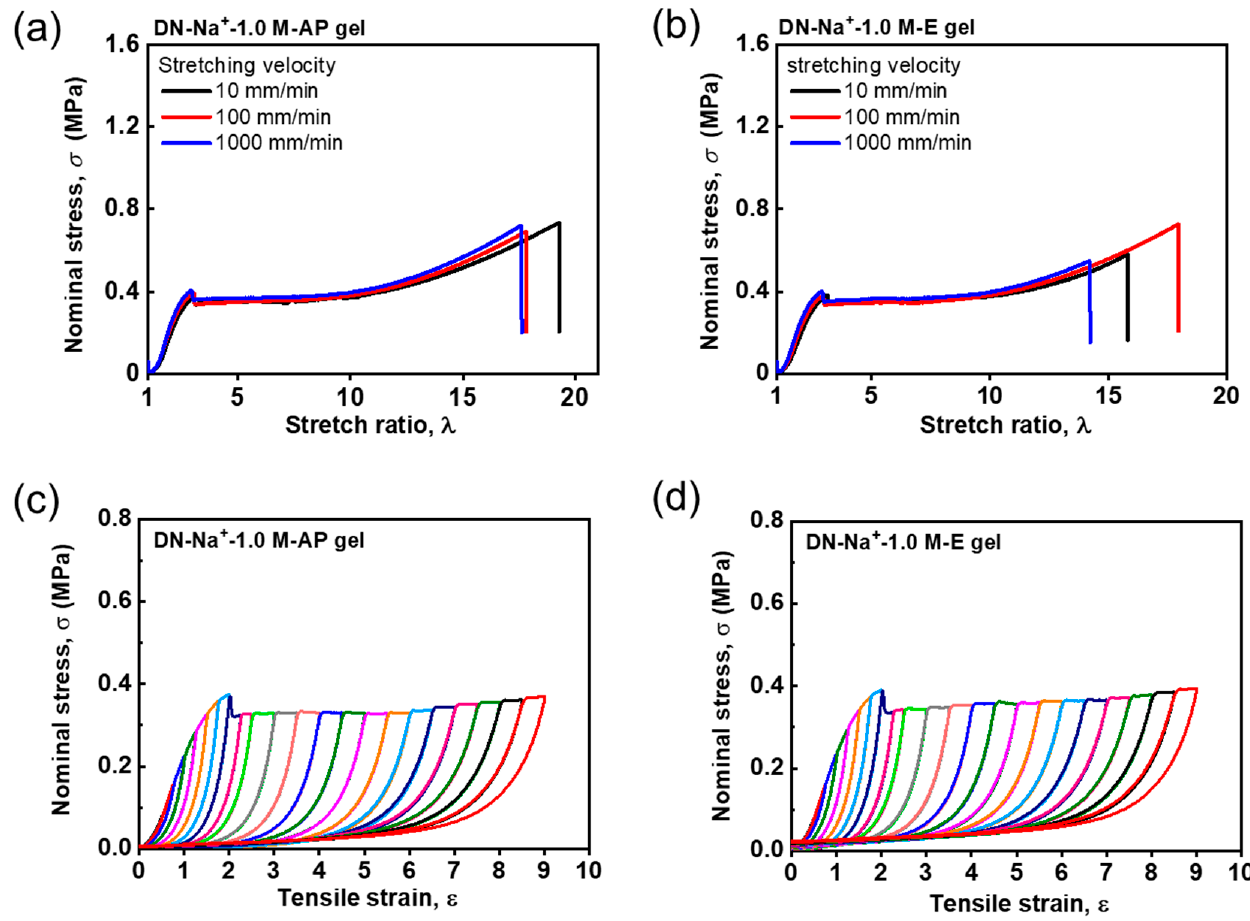
Figure 5. Tensile behaviors and cyclic tensile behaviors for various DN hydrogels with Na + as metal ions. ( a , b ) Rate-independent tensile behaviors of the DN − Na + − 1.0 M − AP ( a ) and DN − Na + − 1.0 M − E ( b ) hydrogels under different deformation rates ranging from 10 to 1000 mm/min. ( c , d ) Sequential loading–unloading cycles for the DN − Na + − 1.0 M − AP hydrogels ( c ) and DN − Na + − 1.0 M − E hydrogels ( d ) at a deformation rate of 100 mm/min. The rate-independent elastic DN − Na + − 1.0 M − AP and DN − Na + − 1.0 M − E hydrogels show completely irreversible hysteresis.